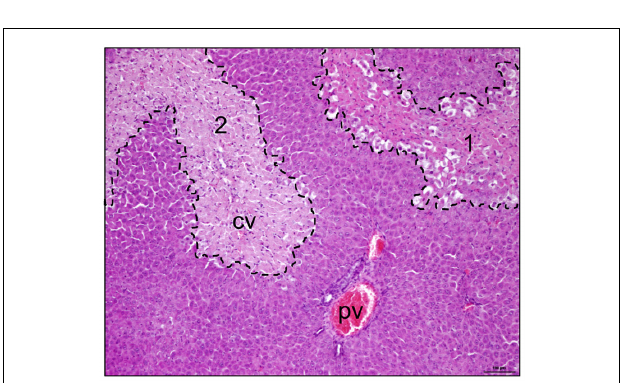
FIGURE 2 | Pericentral necrosis after acetaminophen intoxication. Rats were treated with a repeated oral dose of 4g/kg body weight of acetaminophen. Eighteen hours later livers were explanted and slices prepared for hemalaun–eosin staining. Dashed lines exemplify initial (area 1) and final necrotic perivenous areas (area 2, cv, central vein) of the liver tissue. Please note that areas around the portal vein (pv) are void of tissue